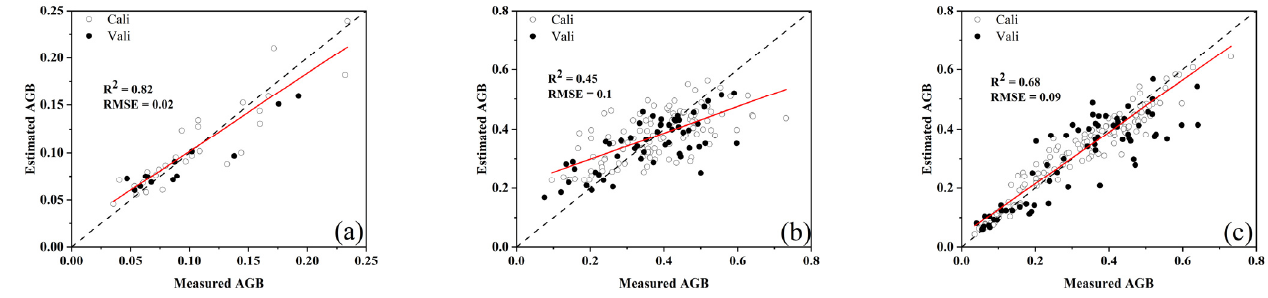
Figure 8. Validation of aboveground biomass (AGB) estimation models established by best performing vegetation index vs. AGB for the following stages: ( a ) seedling, ( b ) post-seedling, ( c ) all stages.